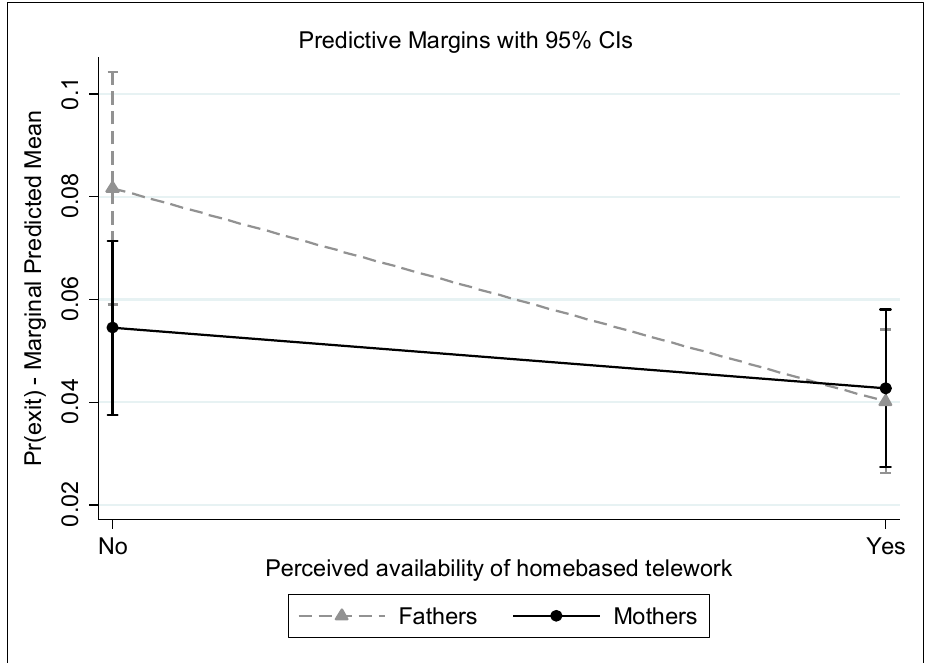
Figure 3. Predictive margins of gender differences for parents in the association between the perceived availability of home-based teleworking and voluntary employee exit. Note. Predictive margins of gender and home-based teleworking with 95% CIs using stata are based on the mixed-effects regressions in Table 4.